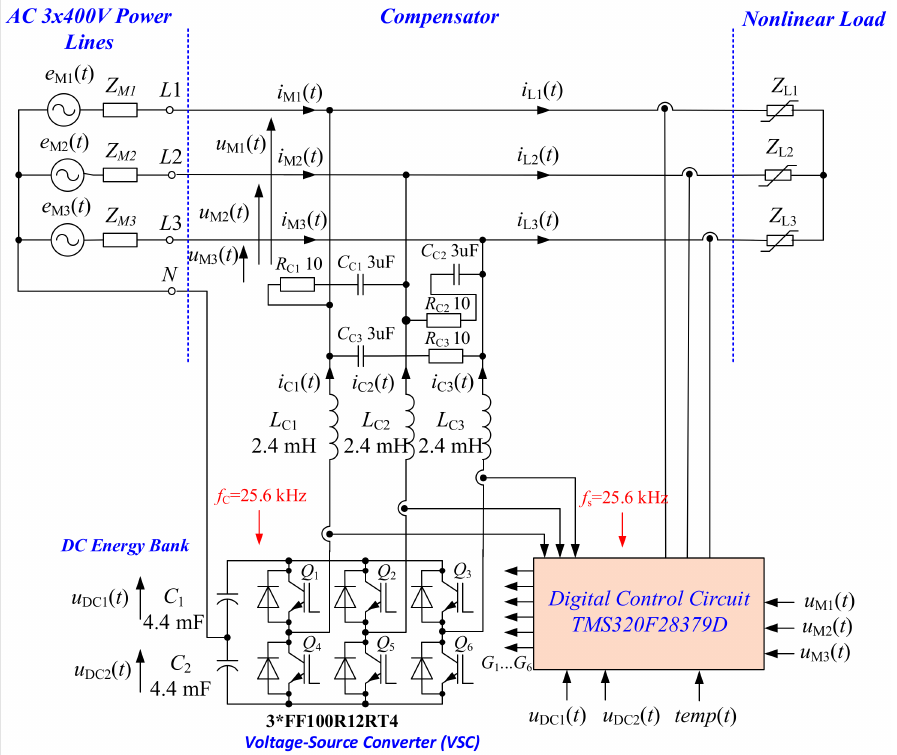
Figure 2. Three-phase active power filter compensation circuit.